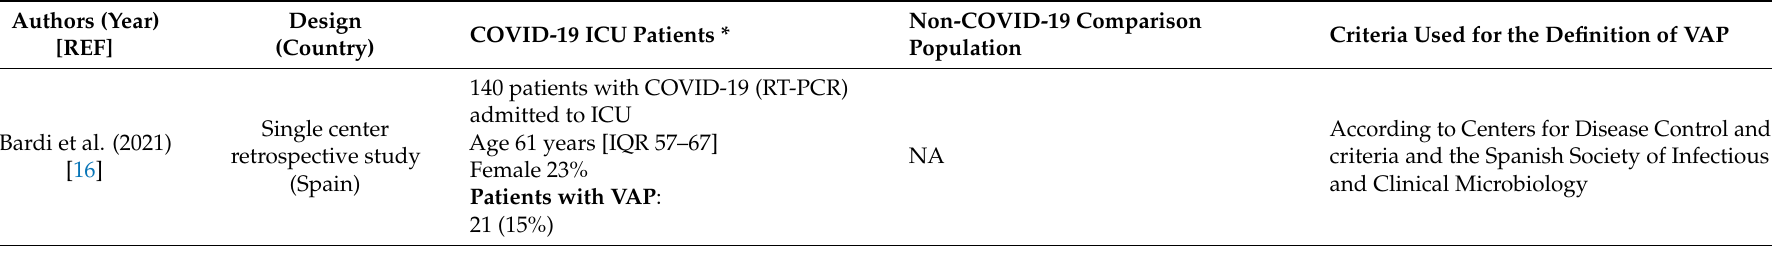
Table 1. Characteristics of the included studies. The table shows the characteristics of the included studies, as reported by the authors. Data are reported as proportions, percentages, median [IQR] and mean ( ±